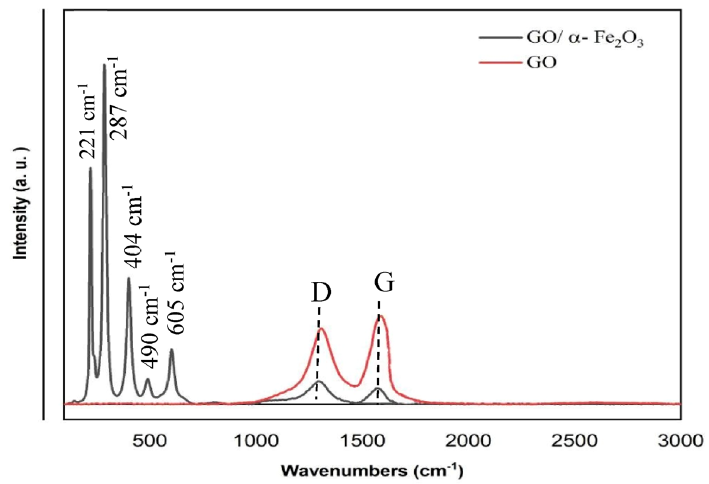
Figure 5. Raman spectra of GO and GO/α-Fe2O3.